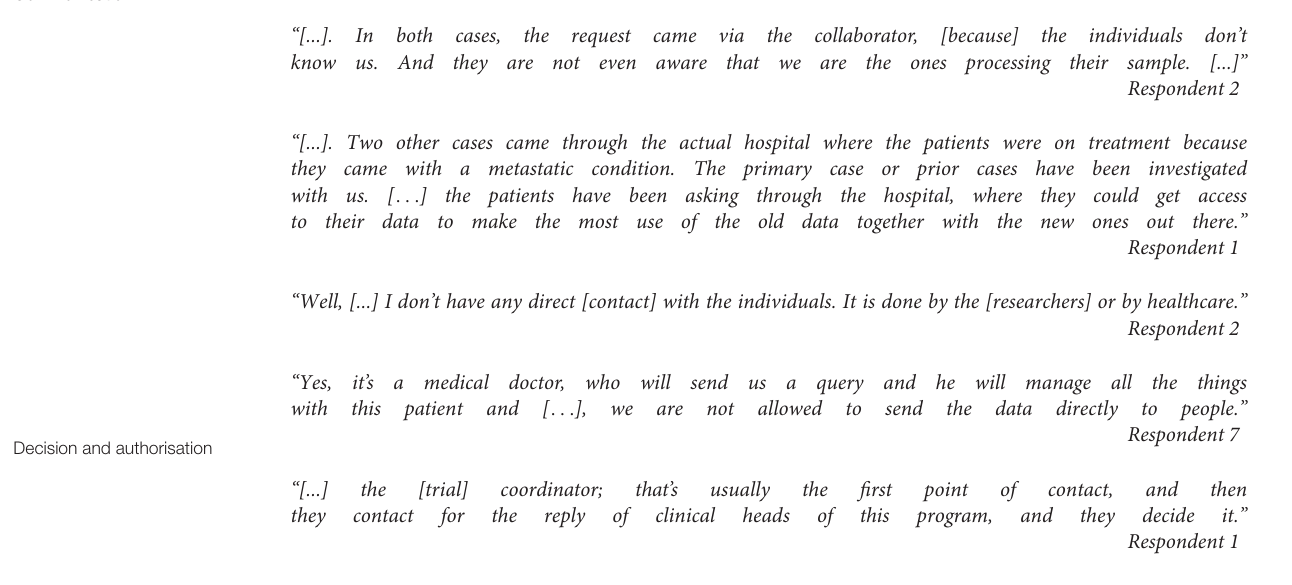
TABLE 1 | Communication, decision, authorisation, and data transfer related to personal access to genomic data.